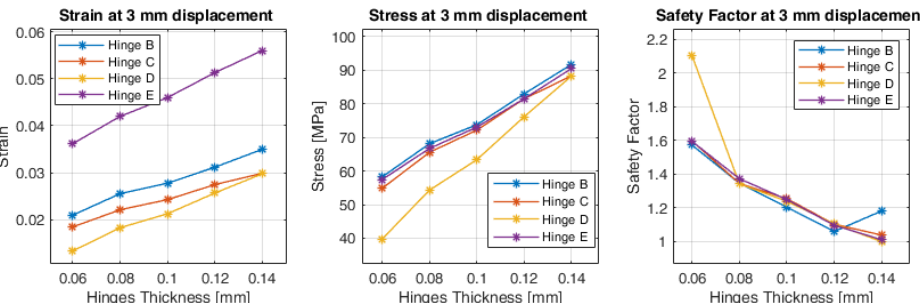
Figure 7. Results of the FEM modal analyses conducted by varying thickness of the flexure hinges, with the output plate moving in free air at 3 mm displacement. For each flexure hinge, the graphs show computed strain, stress, and safety factor